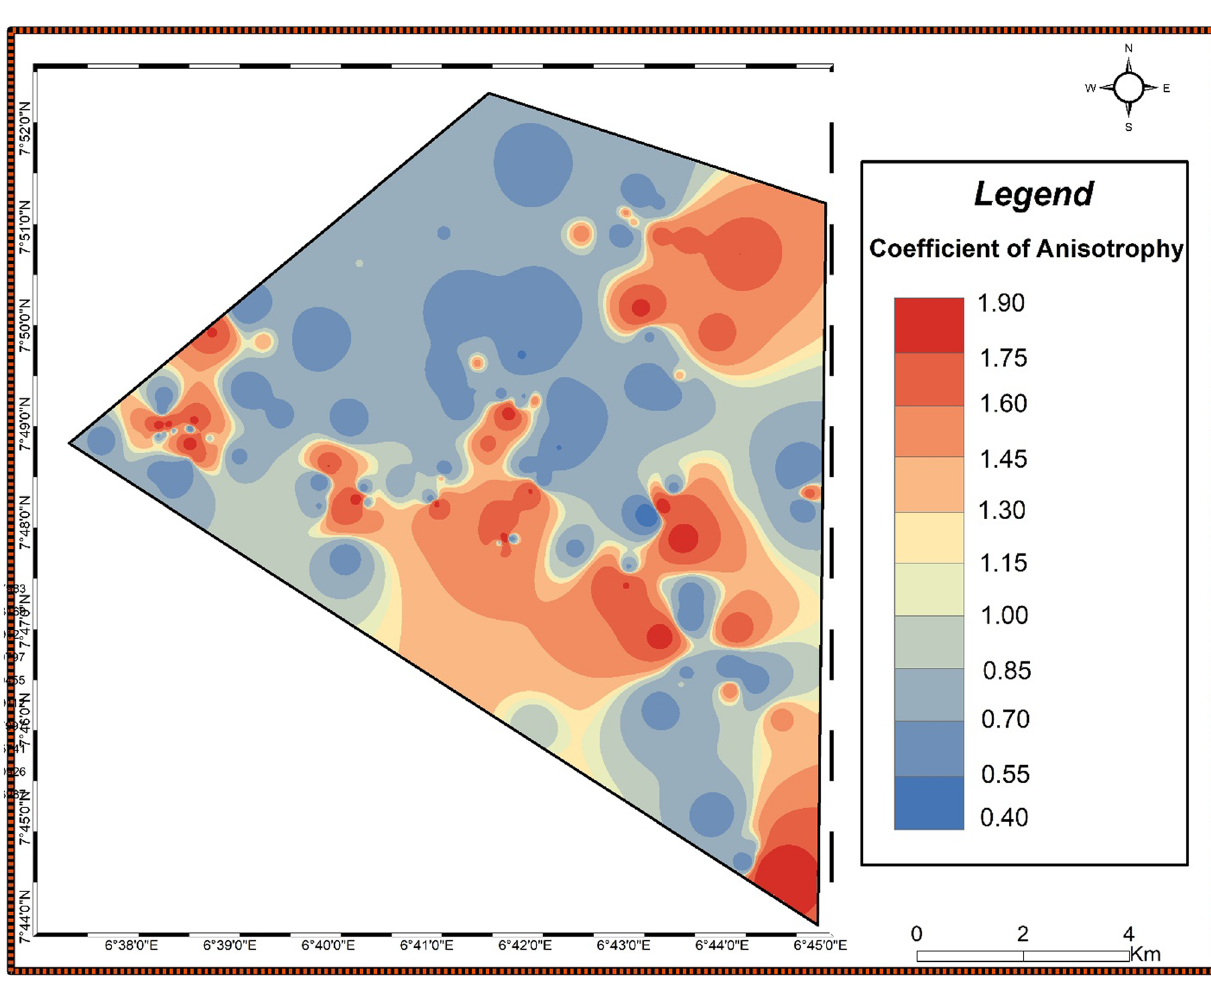
Fig. 7 Map showing the spatial distribution of coefficient of anisotropy across the study Omobude (2017) in which sets of values were distributed into classes of an equal number of values. The region groundwater potentiality prediction index (GPPI) maps were generated in a GIS setting using the classification ranges in column 2 of Table 3. The generated ground- water potential yield index map (Fig. 10) classifies the potential rate into three classes (low, medium and high) using a spatial attribute band of < 1.4, 1.4–2.6, and > 2.6 (Table 3). The corresponding percentage area covered in each groundwater potential zone is described in Table 3.